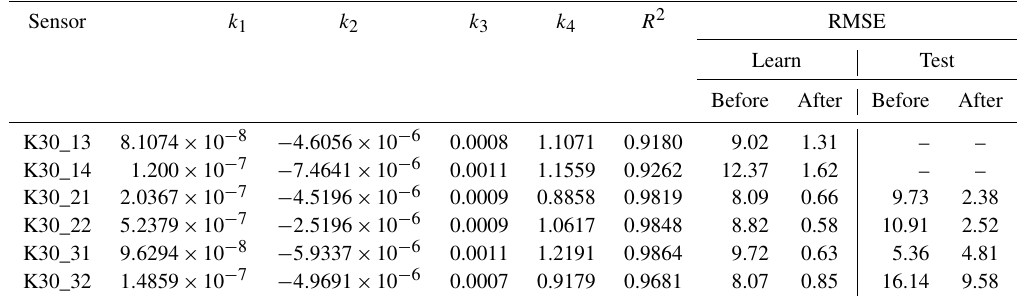
Figure 8. Time-series data for the chambered relative humidity experiment after applying the correction method. The solid black curve represents the relative humidity inside the chamber. The yellow, green, and red curves represent the CO 2 values reported by the test sensors. The dashed blue curve represents the CO 2 values reported by the reference sensor. Table 3. Coefficients from the relative humidity correction method. The RMSE values are relative to the reference sensor inside the test